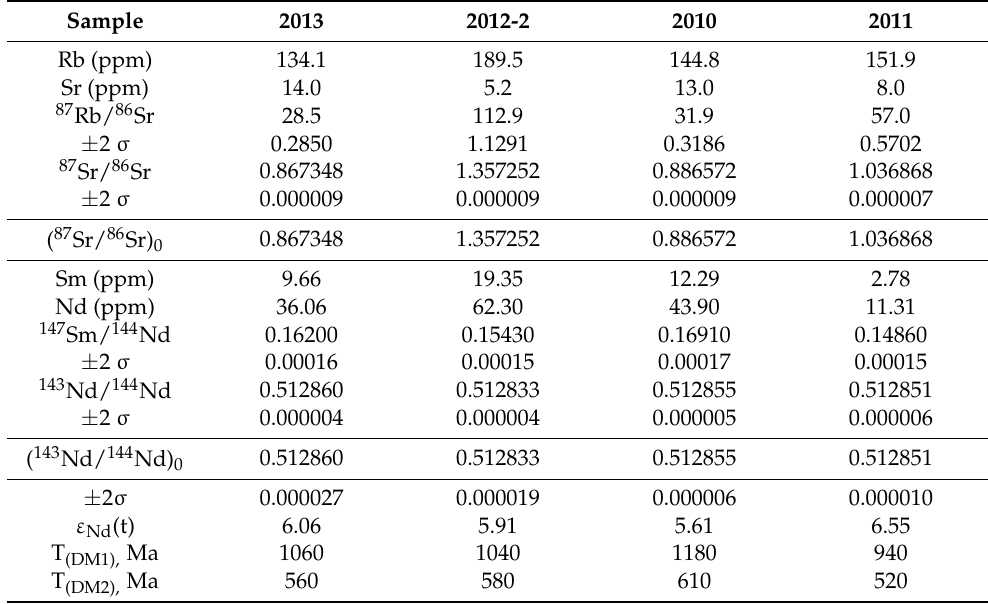
Table 3. Sr-Nd isotopic compositions for representative samples of the Middle Devonian peralkaline A-type granitic rocks from Tannuola